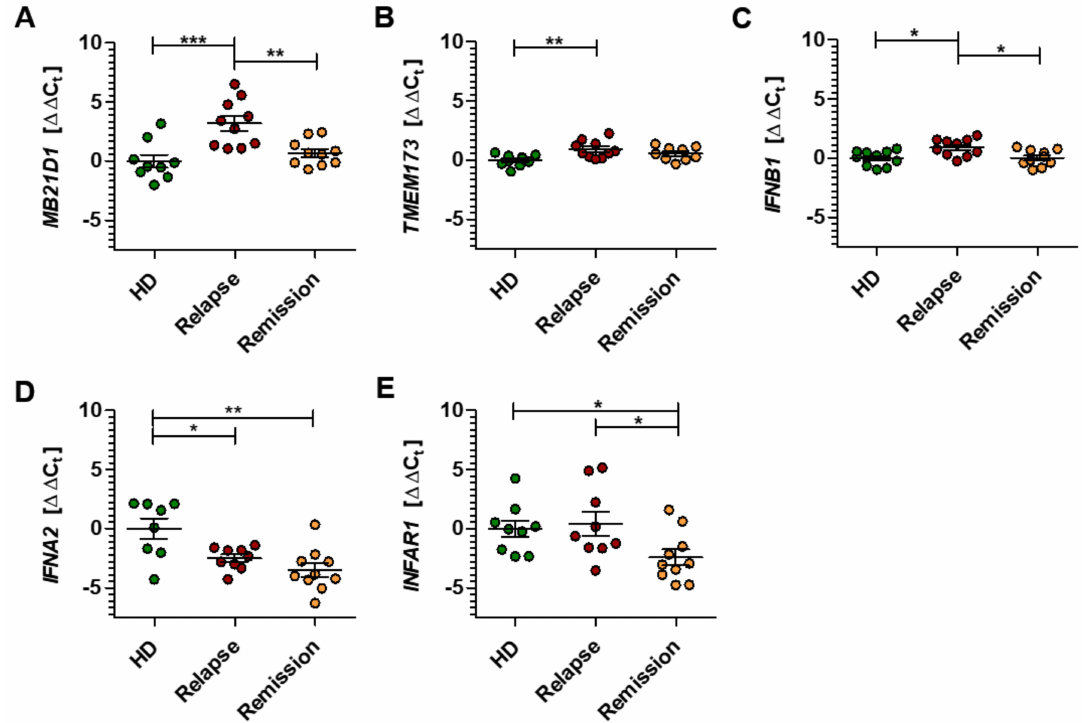
Figure5. GeneexpressionpatternoftheSTING / IFN- β -axisinpatientswithmultiplesclerosis. ( A–E